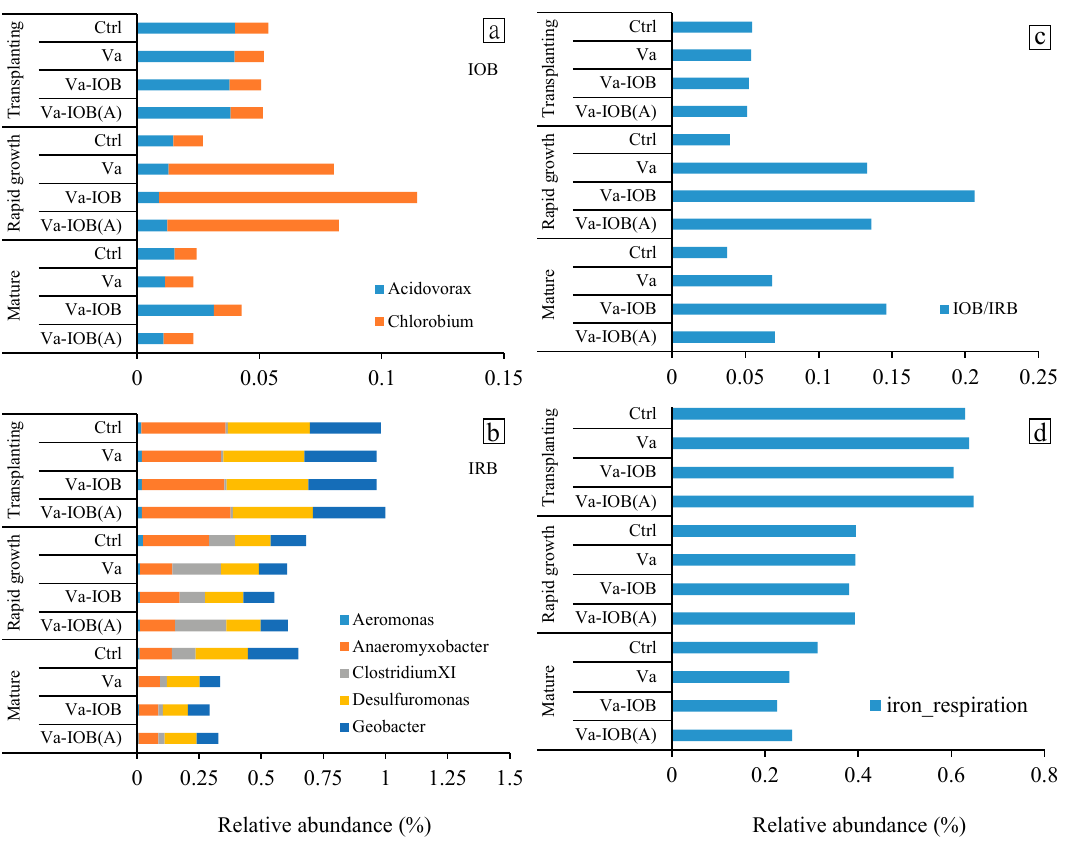
Figure 6. Key bacterial genera related to ( a ) iron oxidation and ( b ) iron reduction, ( c ) the ratio between iron-oxidizing bacteria (IOB) and iron-reducing bacteria (IRB), and ( d ) FAPROTAX-based functional prediction of sediment bacteria related to iron respiration under different treatments.